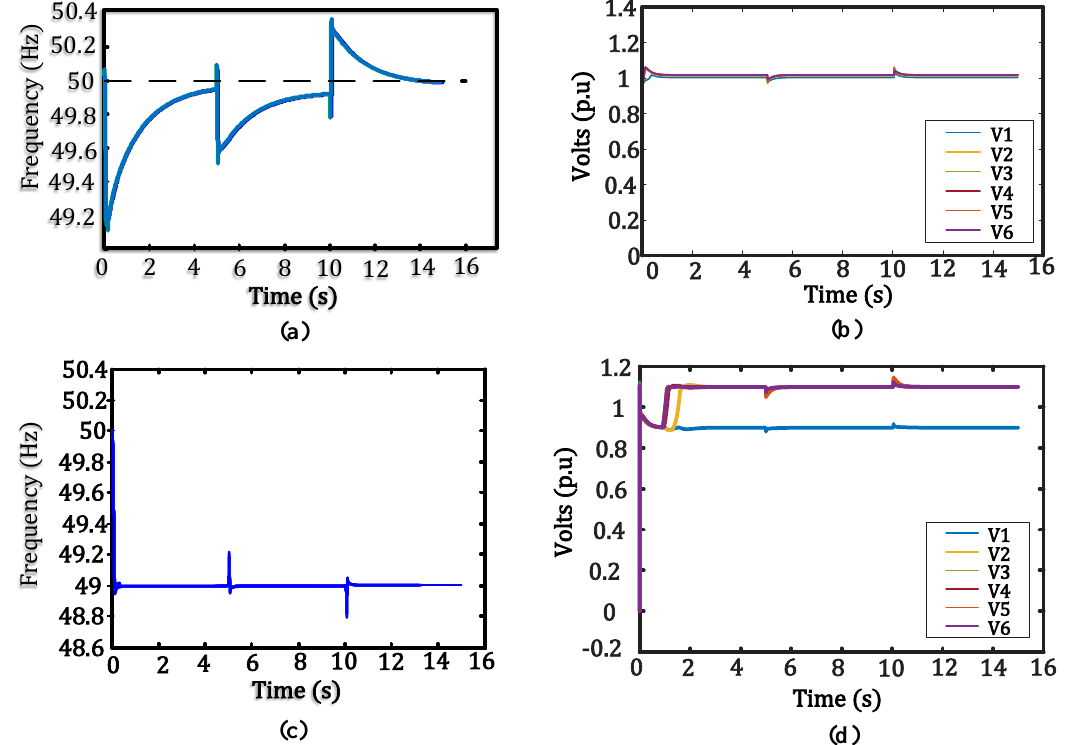
Figure 6. System performance under communication failures: ( a ) Frequency restoration with the proposed control strategy; ( b ) Voltage restoration with the proposed control strategy; ( c ) Frequency restoration with consensus-based control; ( d ) Voltage restoration with consensus-based control. Table 5. Comparison of the proposed control strategy with existing conventional Strategies. Sr.